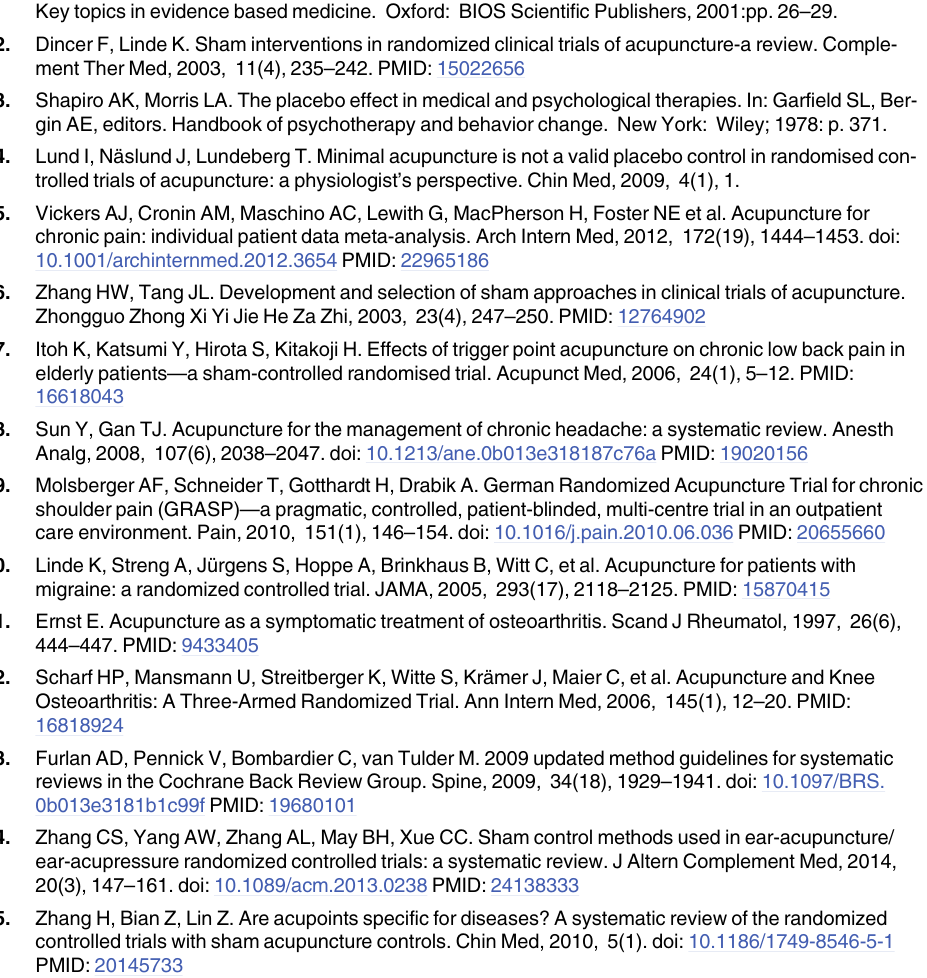
S1 Table. Selected Searching Strategies. S2 Table. Excluded Acupressure Trials due to High Risk of Bias. S3 Table. Risk of Bias Assessment of the Included